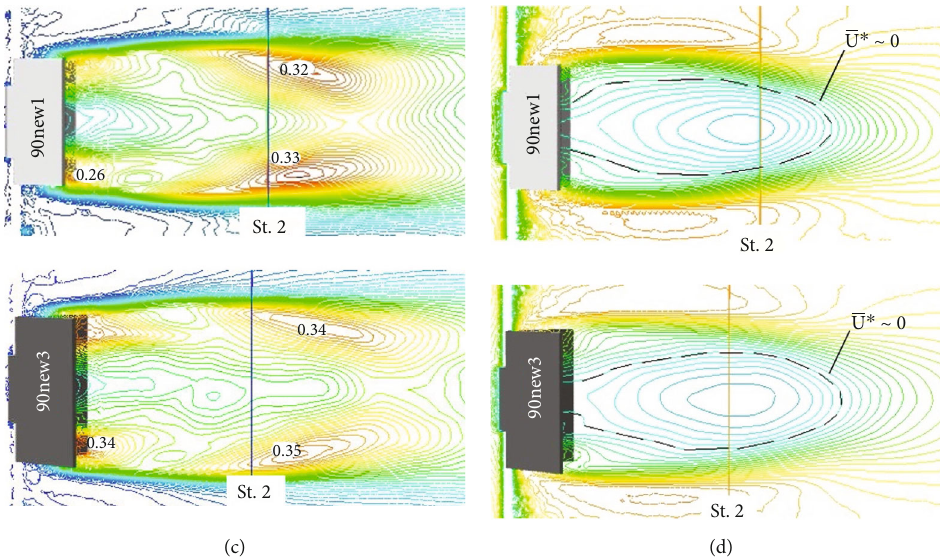
Figure 9: Isosurface of normalized Q − criterion = 0 : 1 colored by mean cp : (a) 90new1 and (b) 90new3. (c) Comparison of u ∗ (cid:1) U ∗ (d) Comparison of